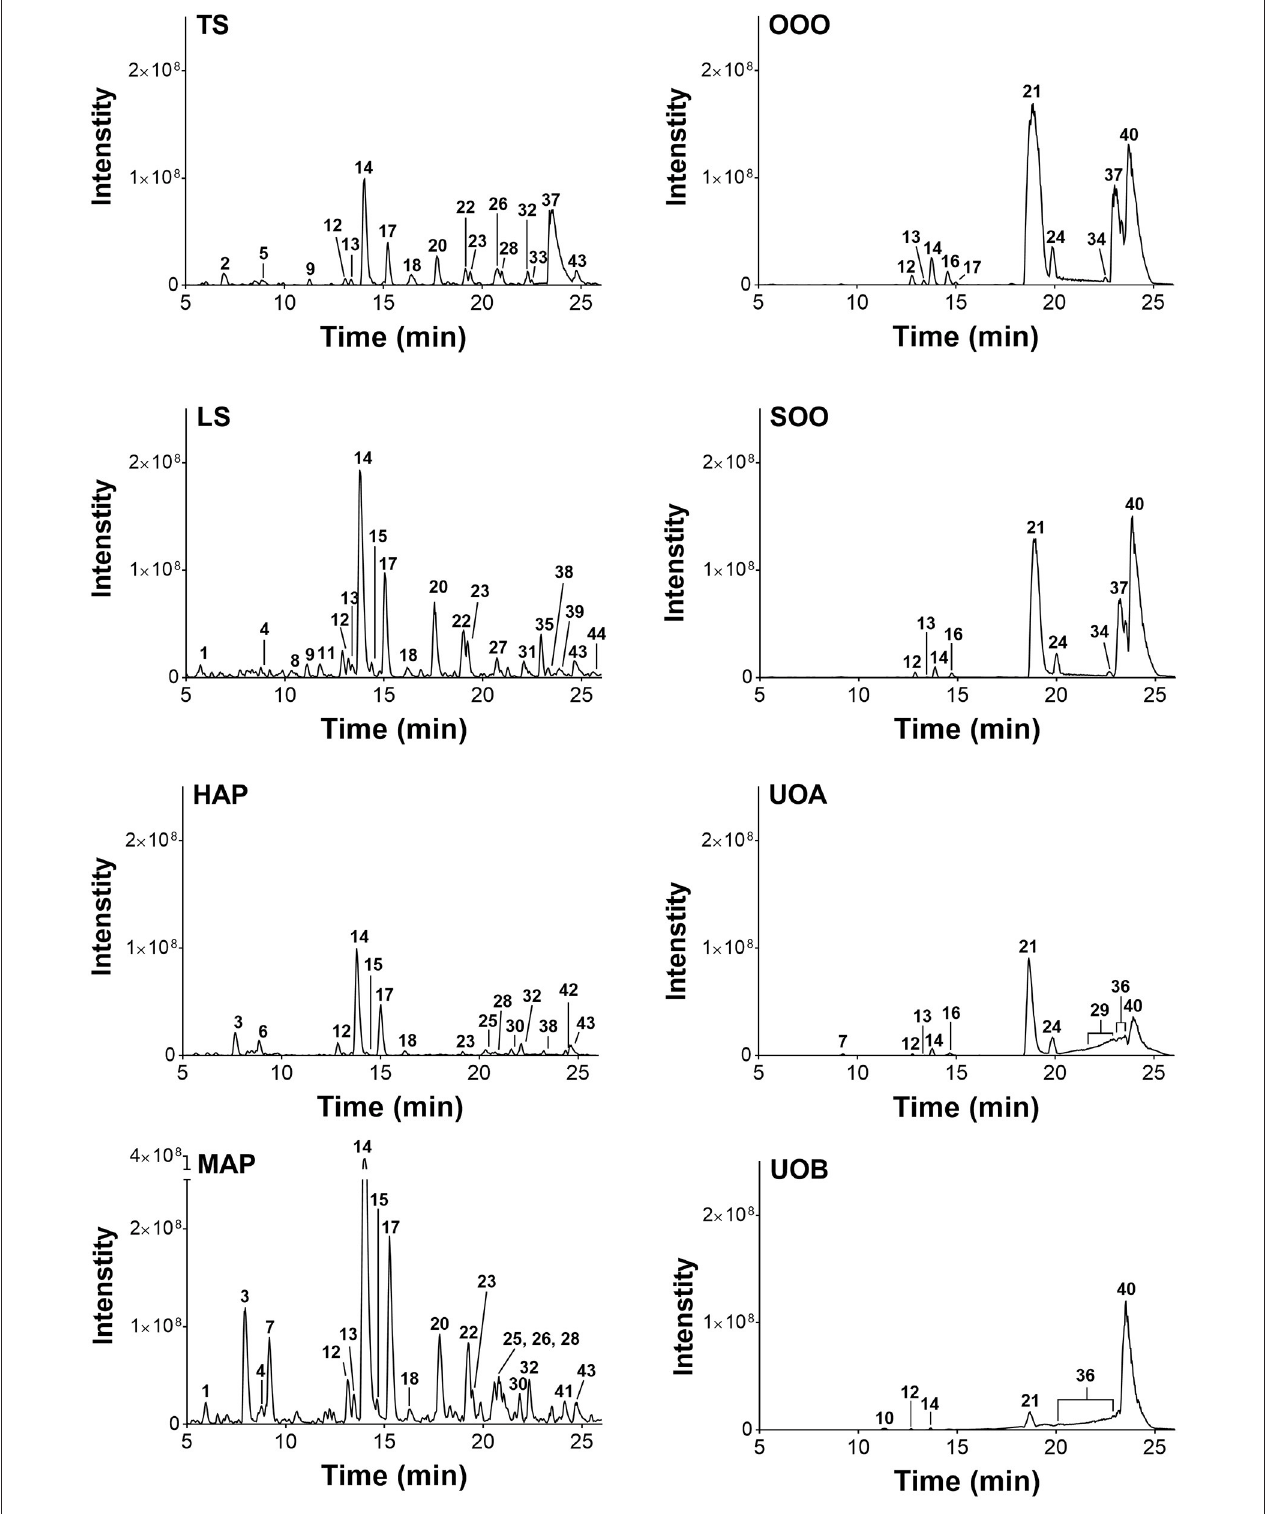
FIGURE 8 | Characterization of H. perforatum extracts by LC-FTMS. Chromatograms of organic and oil extractions of H. perforatum are reported; peak numbers correspond to Table 5 .